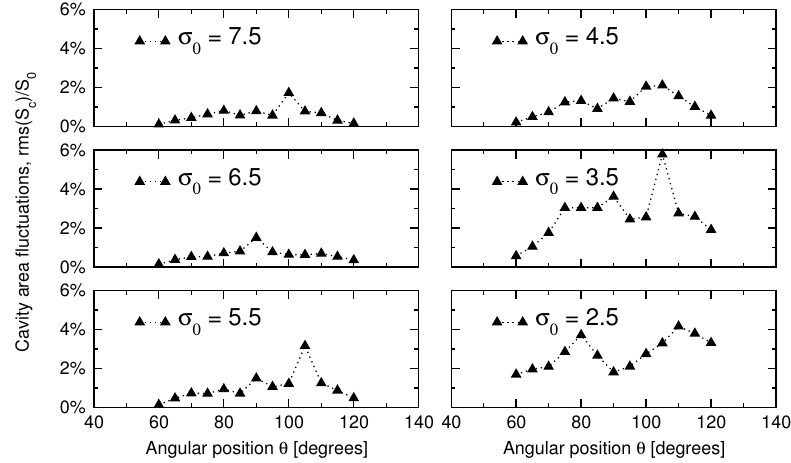
Figure 7. Fluctuations of the cavity extension as a function of the propeller angle θ